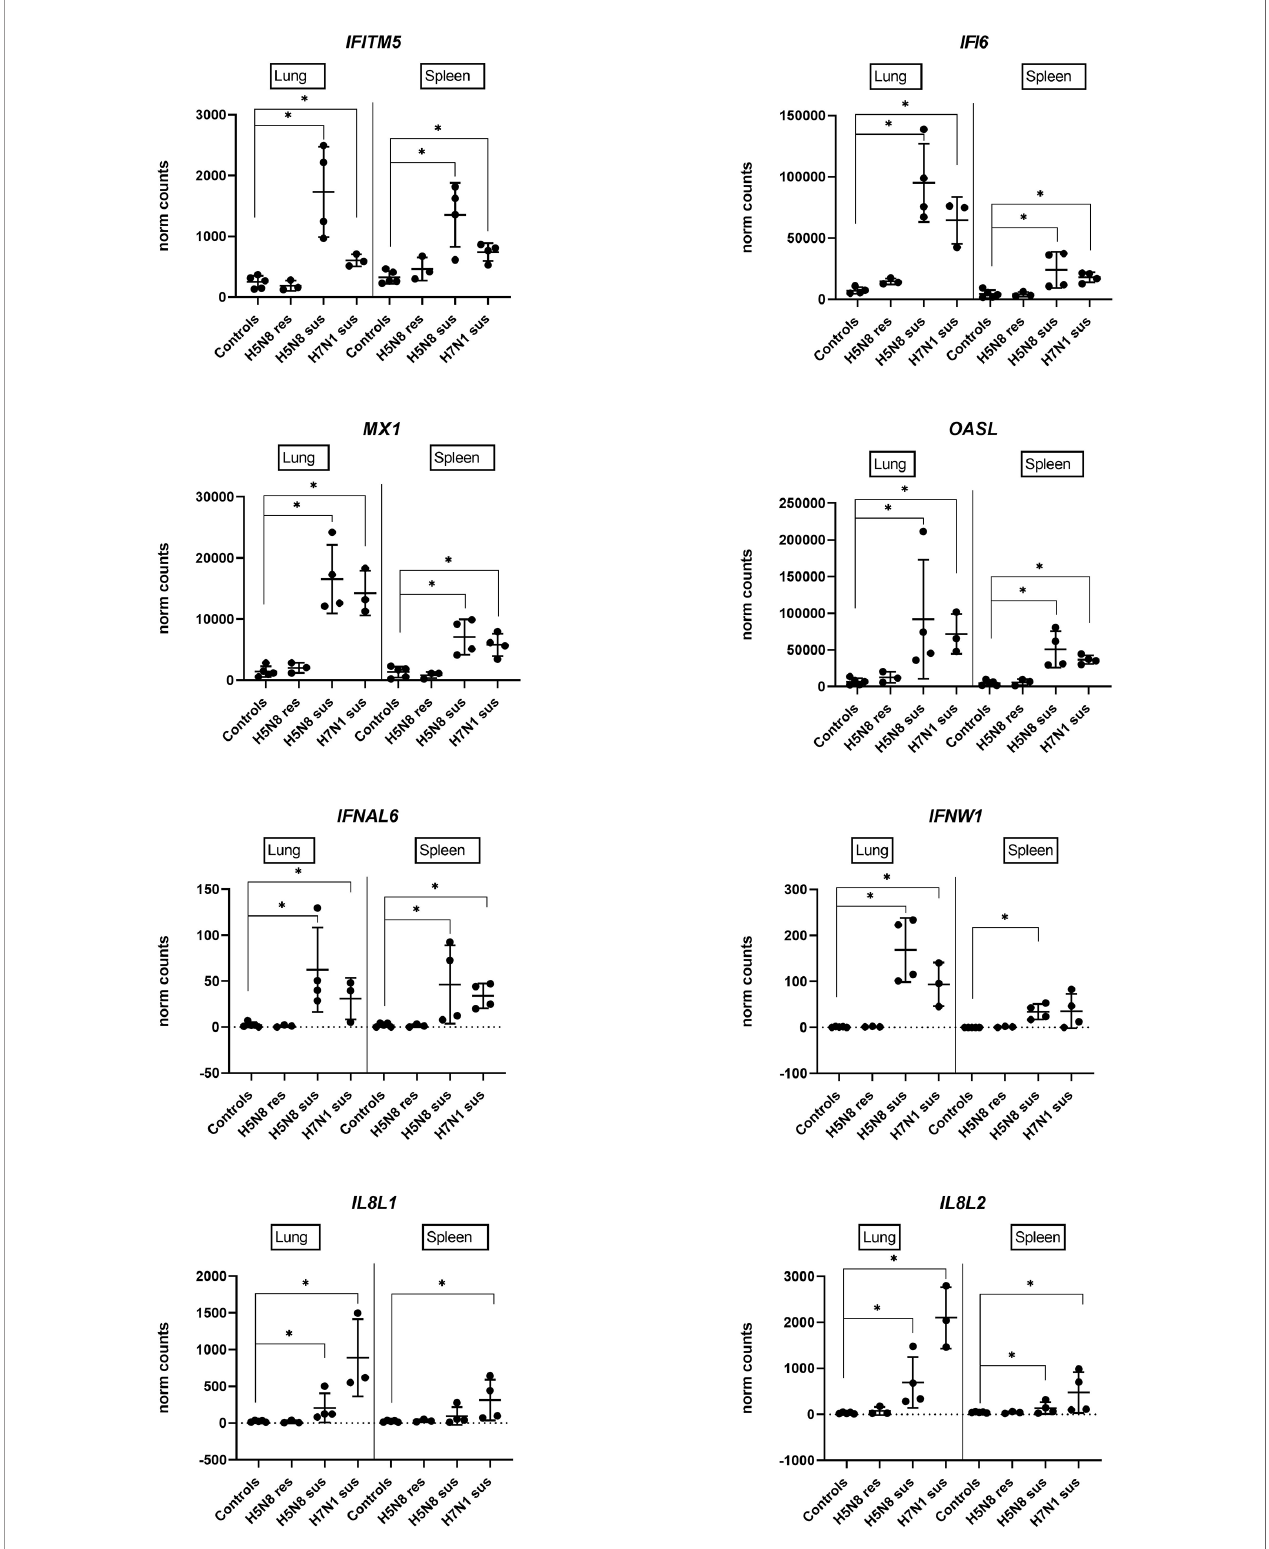
FIGURE 4 | Expression levels of genes representative of IFN-I and in fl ammatory responses in lungs or spleens collected at 3 dpi from H5N8 or H7N1 inoculated chickens based on DEGs obtained by RNA-Seq. ( ∗ ) BH adjusted P ≤ 0.05 from Wald test p-value with DESeq2.